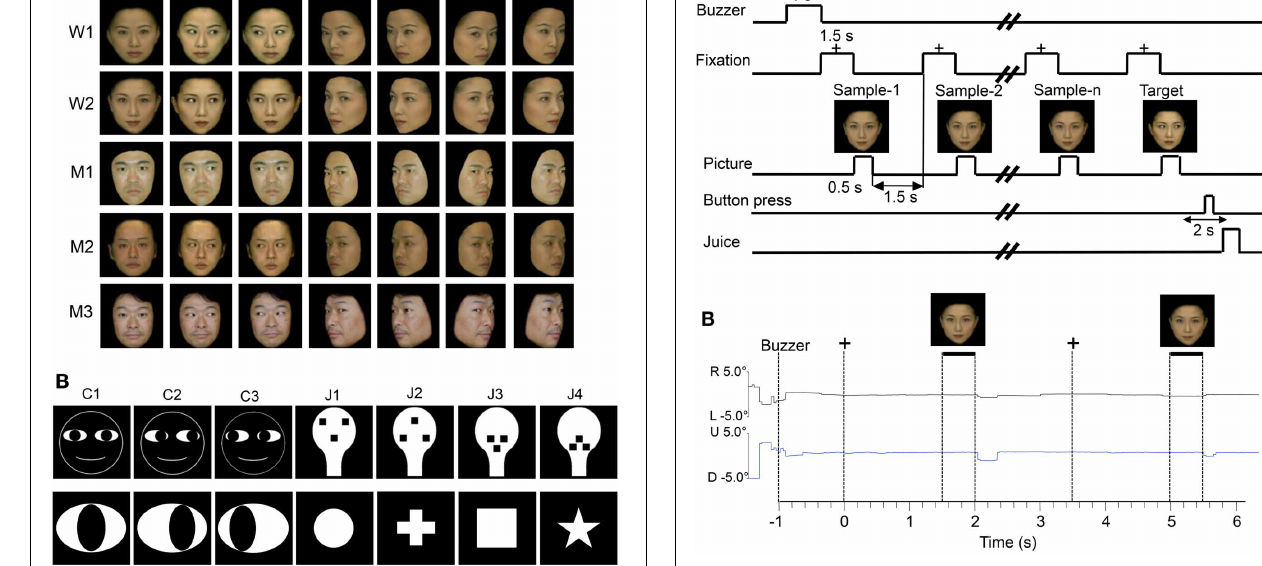
FIGURE 2 | Stimulus sequence in the delayed non-matching to sample (DNMS) task in which stimuli were sequentially presented with a delay between them (A) and examples of eye tracking data during the task (B). + , fixation cross; R, rightward; L, leftward; U, upward; D, downward. the display. When the monkeys fixated on the cross for 1.5 s